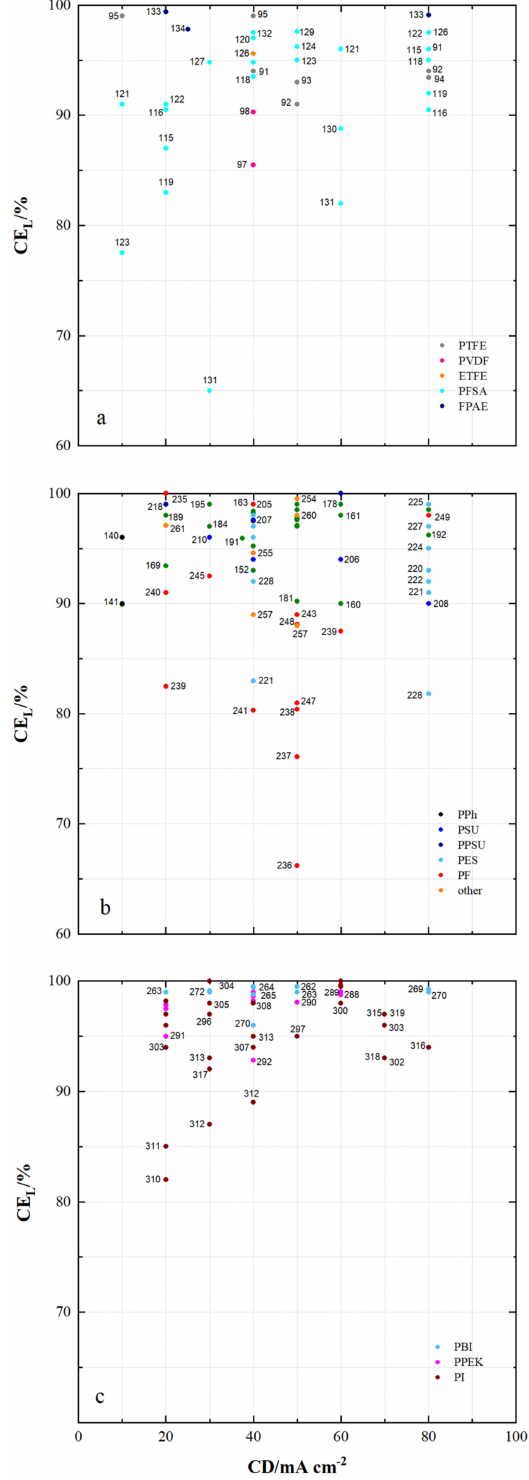
Figure 9. The energy efficiency of VRFB cells by using membrane samples at current